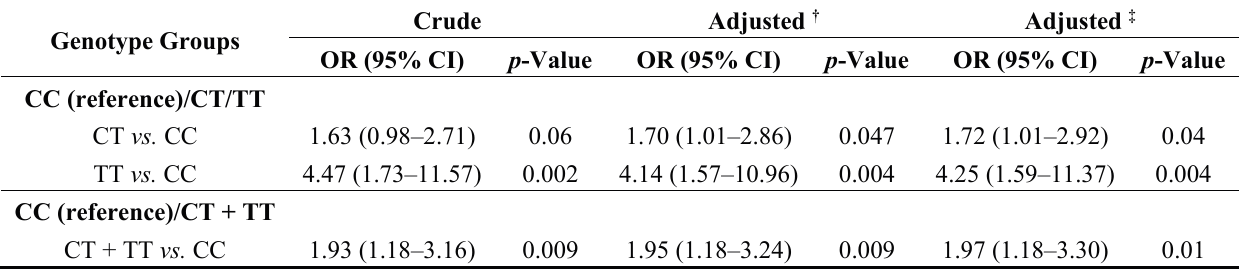
Table 3. The effect of C-reactive protein ( CRP ) gene rs1205 C>T polymorphism on the risk of severe aortic valve calcification * analyzed by logistic regression.